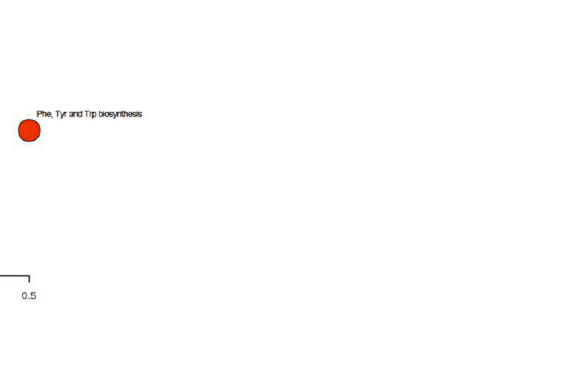
Figure 2. Pathway analysis reveals metabolic alterations in DJ-1 β mutant flies. Pathway enrichment analysis of differentially expressed metabolites between ( a ) 1-day-old DJ-1 β mutant and control flies, ( b ) 15-day-old DJ-1 β mutant and control flies, and ( c ) 1-day-old and 15-day-old DJ-1 β mutant flies. Pathway impact represents the importance and number of altered metabolites in a given pathway, also indicated by the size of the corresponding circle. Colors represent the significance of changes in the pathways. Red color indicates higher values of –lop10( p ) and more significant changes in that pathway. Table 1. Most relevant pathways altered in 1-day-old DJ-1 β mutants compared to control flies. Number of Differential Pathway